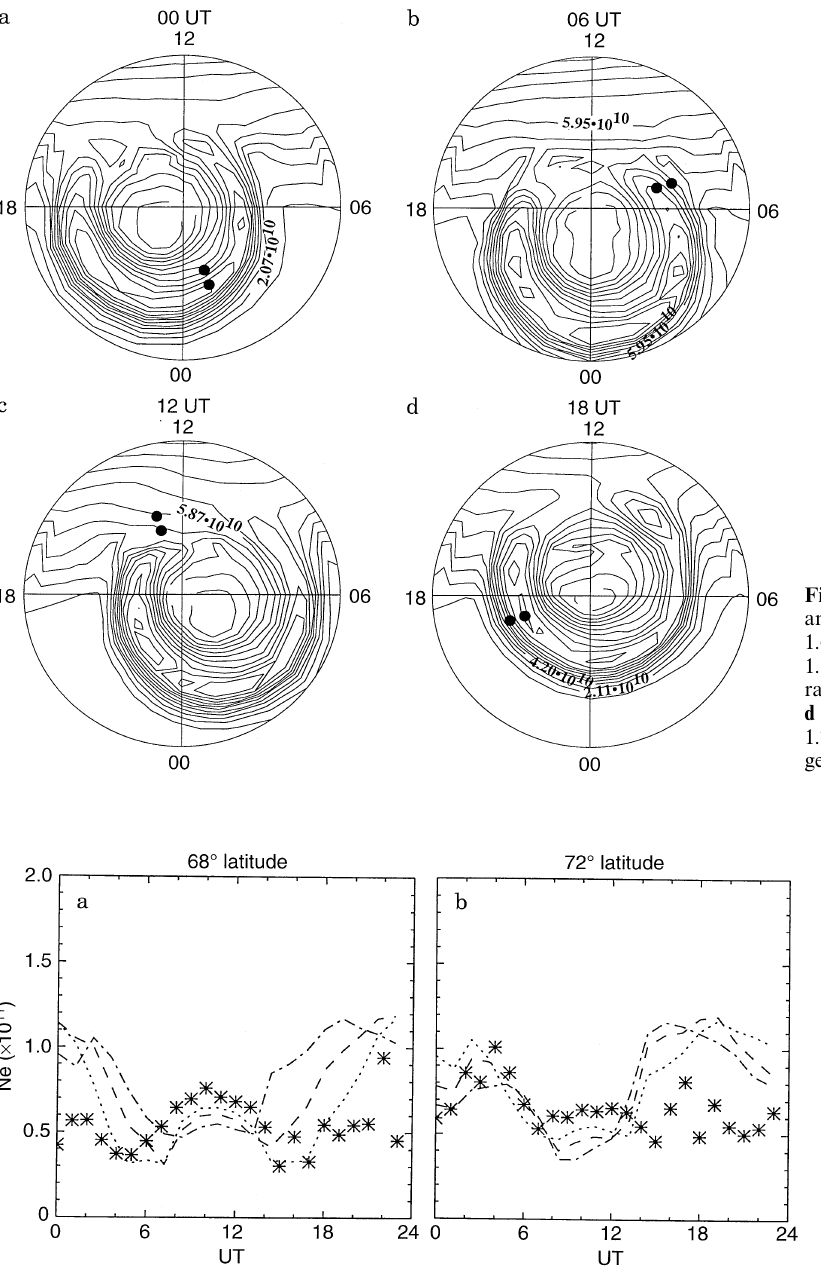
Fig. 4a, b. RUN-DEF Ne ( lines ) and measured Ne ( asterisks ) at 140 km and 18 ° E. a data at 68 ° , b data at 72 ° . The dotted line is at the latitude of the data minus 2 ° , dashed line is at the same latitude as the data, and the dot - dash line is at the latitude of the data plus 2